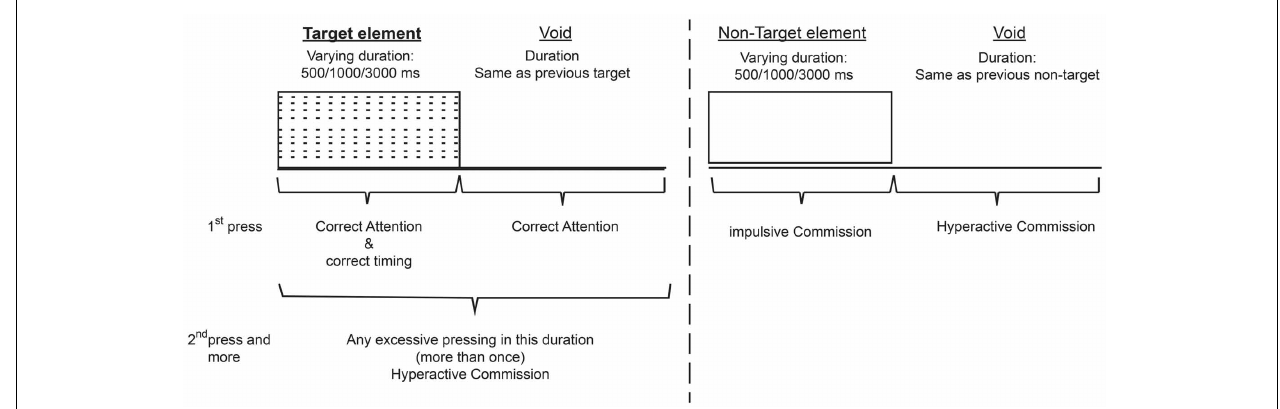
FIGURE 1 | Definition of the time line (Target and non-target stimuli were presented for 500, 1000, or 3000ms. Each stimulus was followed by a void period of the same duration. The stimulus remained on the screen for